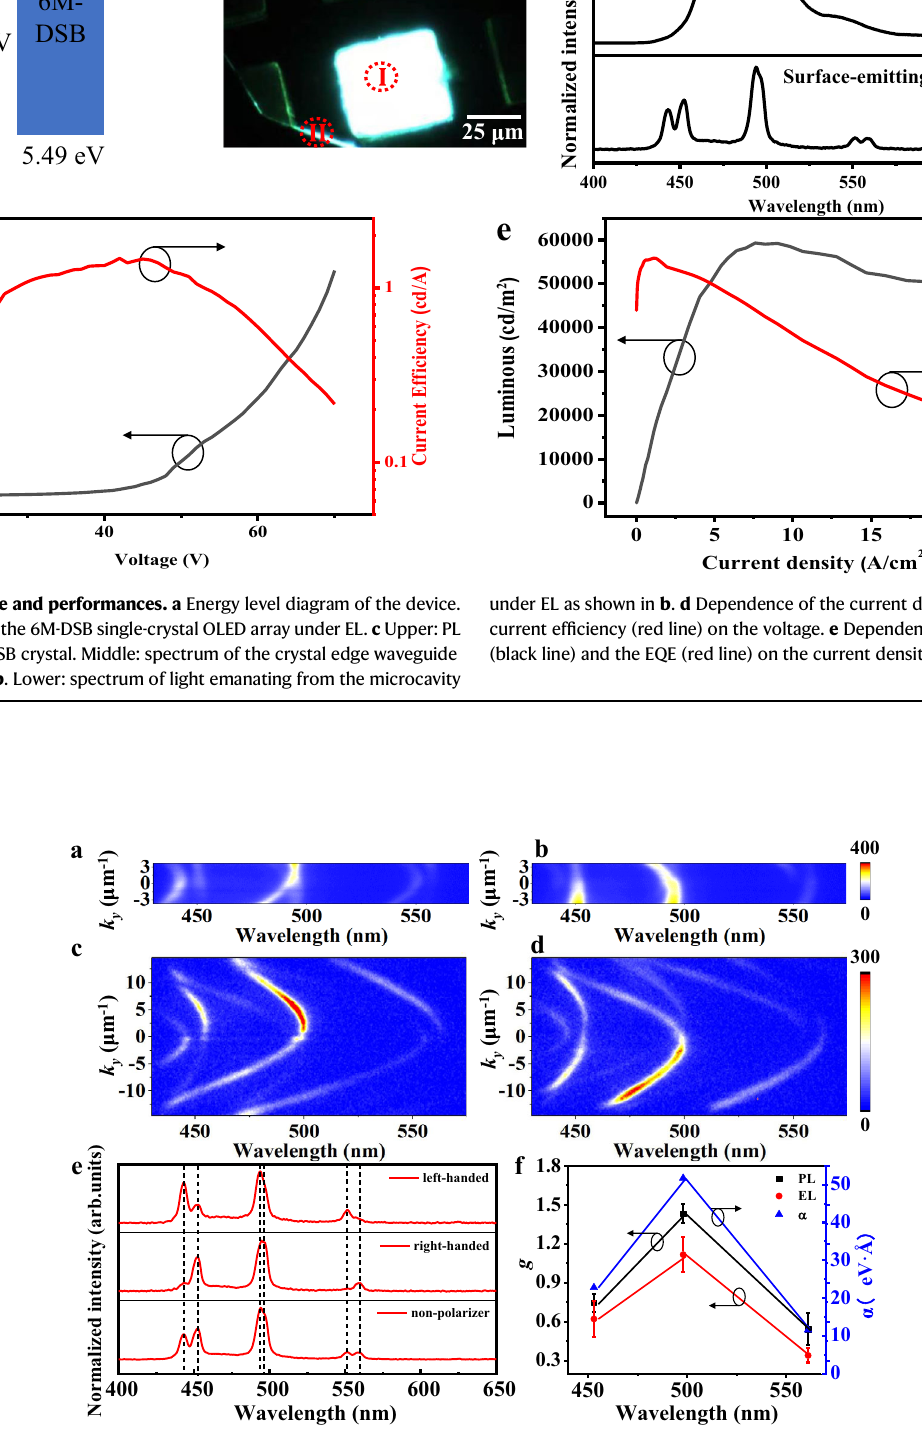
Fig. 4 | Angle-resolved EL measurements. Polarized angle-resolved spectra of EL ( a , b )andPL( c , d ).Theunitsofthecolorbarsarearbitrary. e ELemissionspectraof unpolarized, σ + and σ − components. f Wavelength-dependent spin-splitting